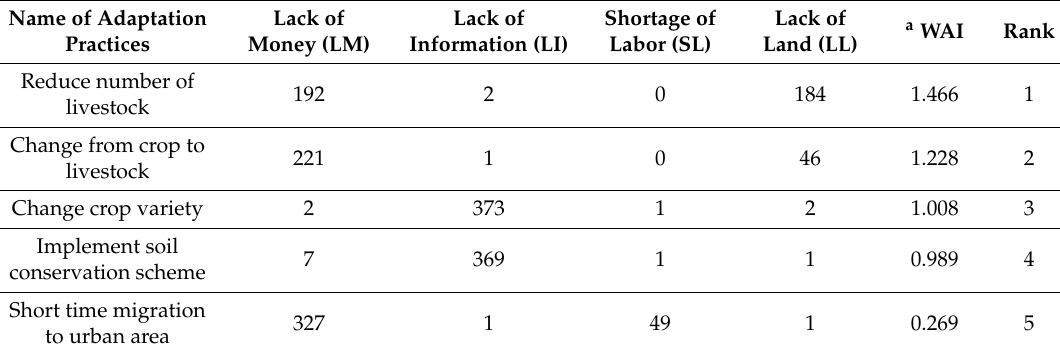
Table 6. Farmers’ ranking of some adaptation